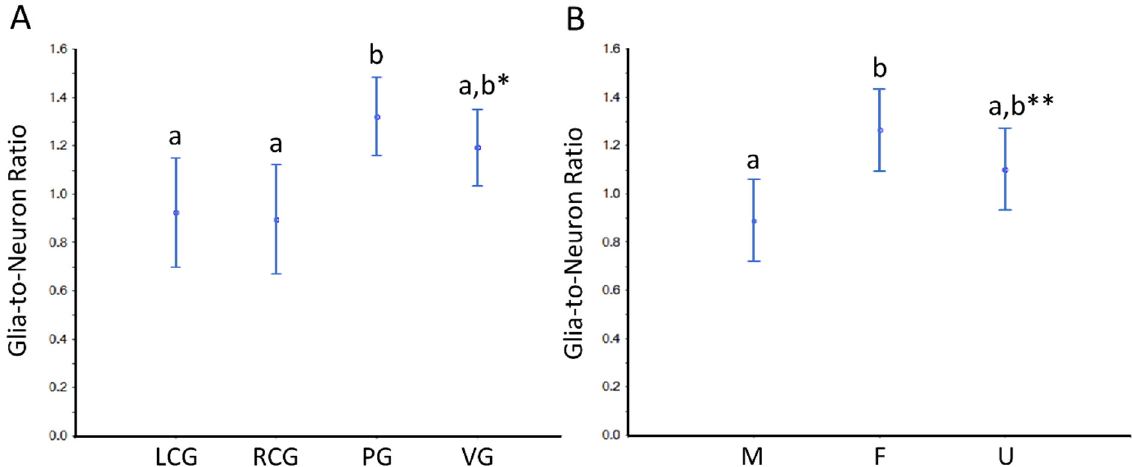
Figure 11. Glia-to-neuron (number) ratio in the cortex of the ganglia of S. plana . ( A ) Data per ganglion type, irrespective of sex condition. ( B ) Results from all ganglia, grouped per sex condition. Different letters mean significant differences ( p < 0.05). Data as mean and 95% confidence interval. LCG: left cerebral ganglion; RCG: right cerebral ganglion; PG: pedal ganglion; VG: visceral ganglion; M: males; F: females; U: undifferentiated. * Trend toward a significant difference between VG and both LCG and RGC ( p ≈ 0.05). ** Trend towards a significant difference between M and U ( p ≈ 0.05). Six animals per sex condition were used.